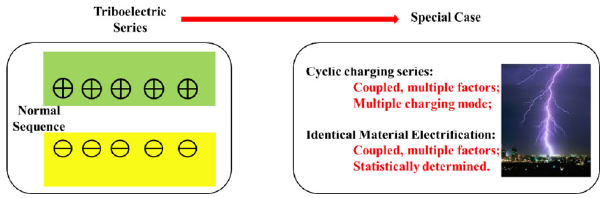
Fig. 8 Understanding for triboelectric series (“Special Case” refers to the triboelectric series composed of (a) identical materials in Section 3.1 and (b) cyclic material loop in Section 3.2).